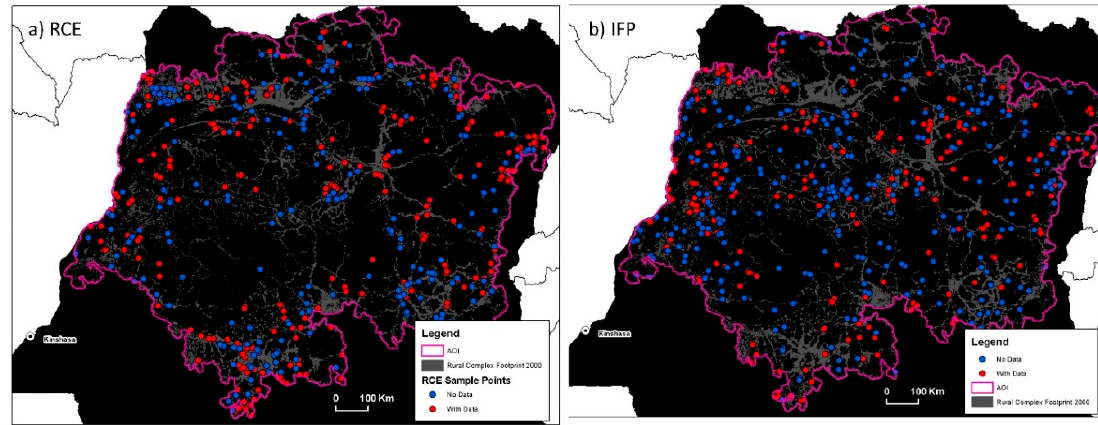
Figure 12. The distribution of no-data sample points within the sample appears to be geographically random and not clustered.